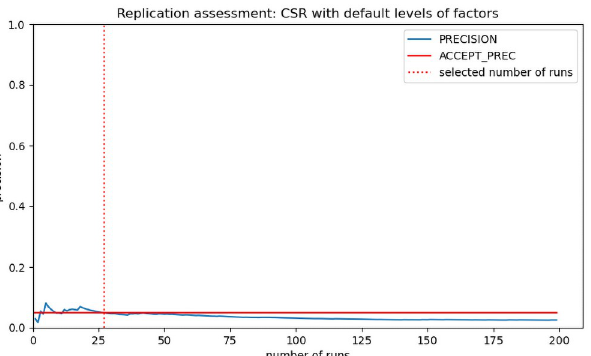
Fig 4. Replication assessment with default levels of factors. The precision is shown by the blue line and indicates the statistical validity of the simulation results at a given number of runs. The threshold for the accepted precision of 5% is shown in red. The number of runs we selected for the simulation experiments and where the precision is consistently below 5% is shown by the dotted line in red.